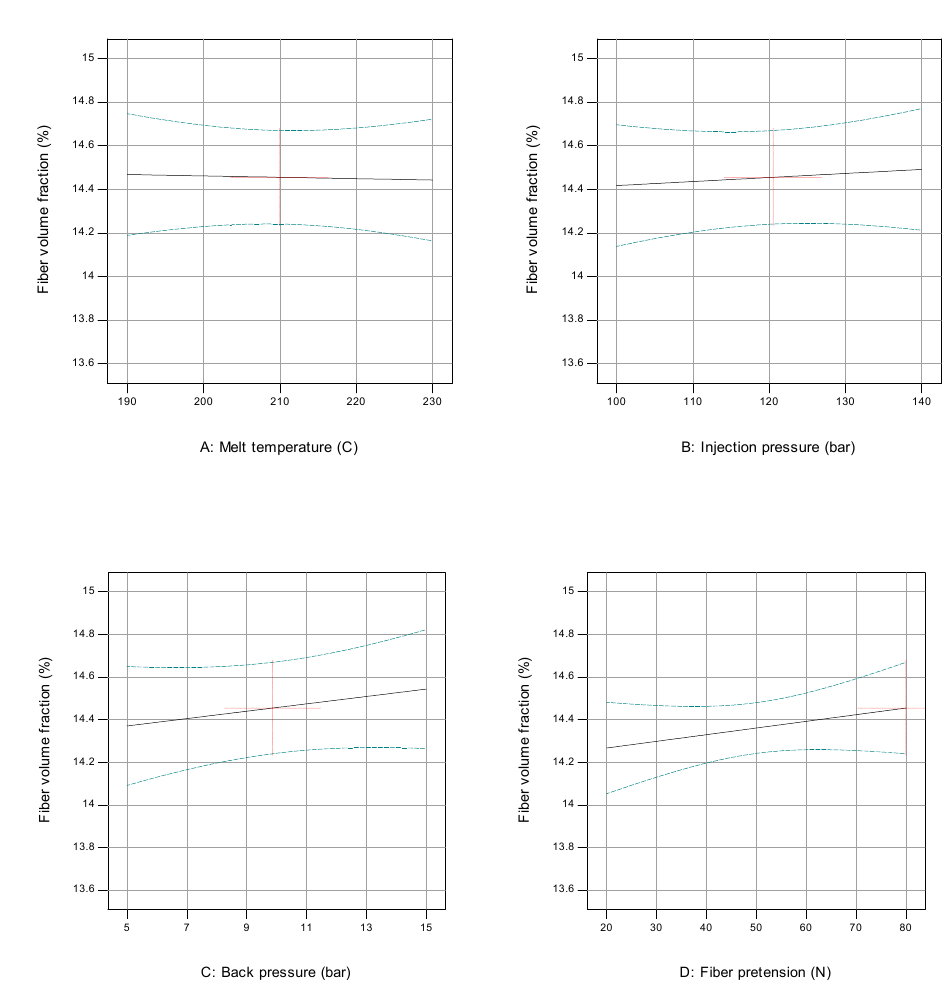
Figure 9. Effect of all factors on fiber volume fraction: ( A ) melt temperature; ( B ) injection pressure; ( C ) backpressure; and ( D ) fiber pretension.